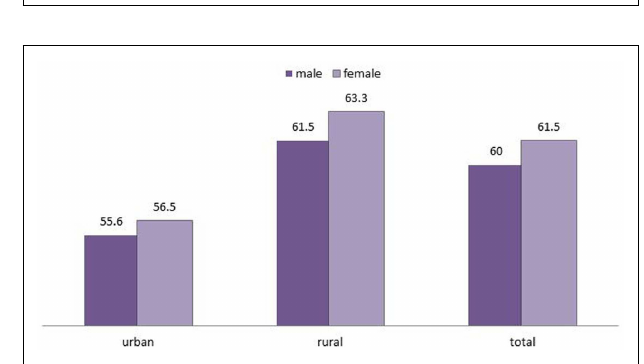
FIGURE 3 | Percentage of children under the age of 5years having anemia by regions and India .